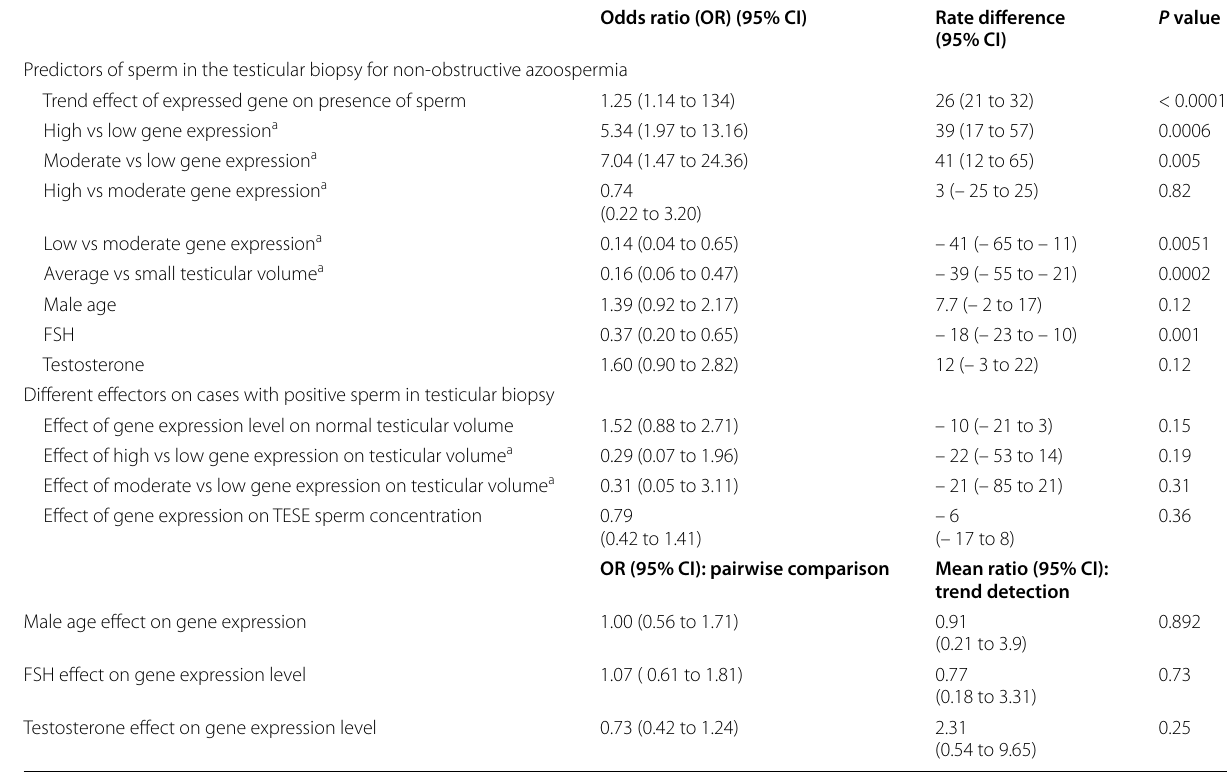
Table 2 Predictors of sperm in the testicular biopsy and relative effects of gene